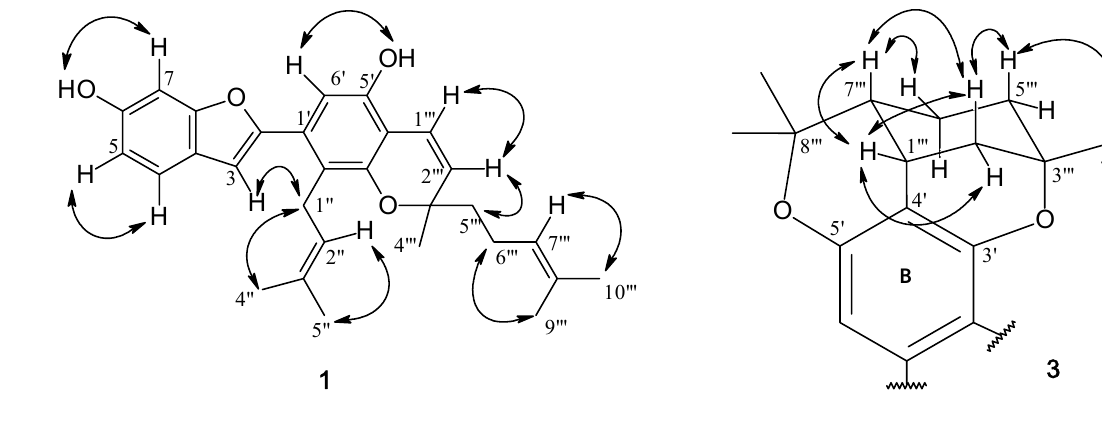
Figure 2. Important NOESY correlations of 1 and 3